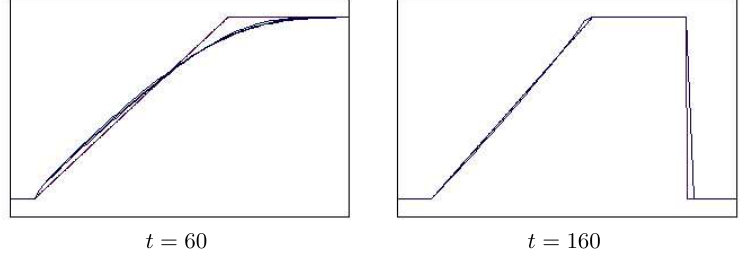
Figure 3. Numerical solution obtained using implicit scheme with upwind difference for 3